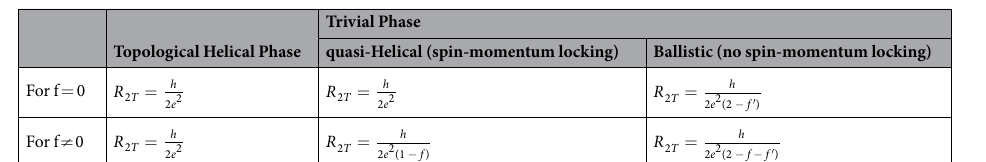
Topological Helical Phase